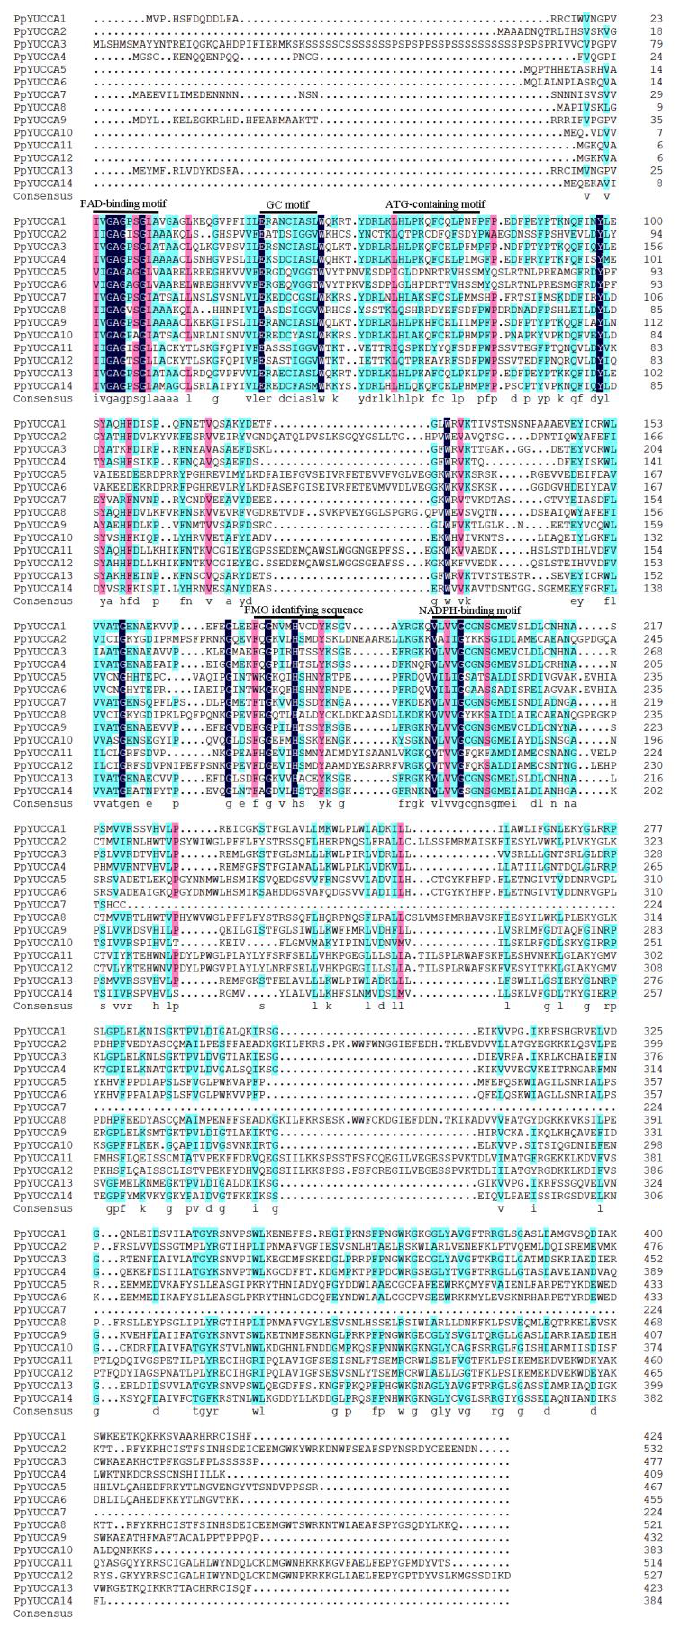
Figure 4. Multiple sequence alignment of Prunus persica var. pendula YUCCA gene family.